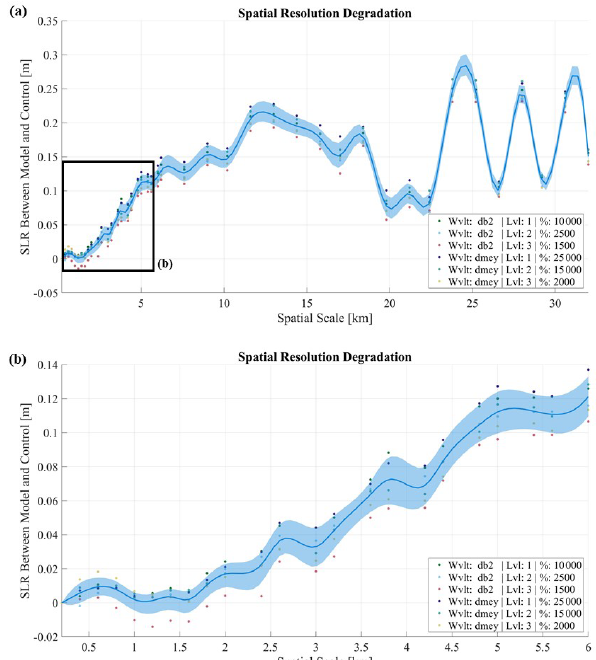
Figure 3. Final SLR is plotted against the current downgraded reso- lution for various noisy bedrock topography ( a , results for all spatial scales; b , results for spatial scales of 6km and finer). The model re- sults (dots) are spline interpolated with trends depicted with a mean resultant line (dark blue line) and a percentile band (shaded region) of ± 1 σ (68.3%). See Appendix (Sect. A2) for further details on bedrock perturbation codes from the